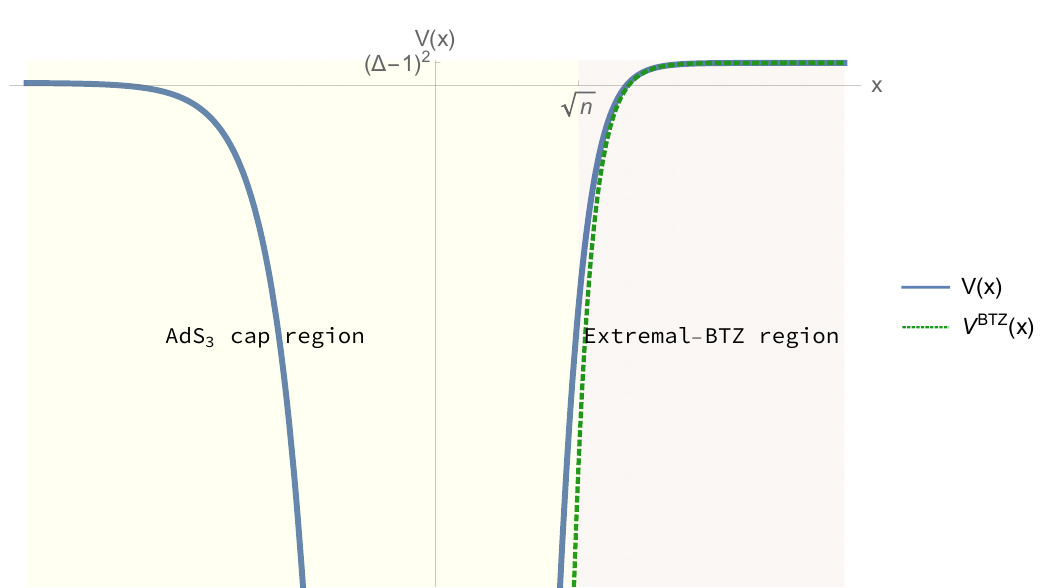
Figure 7: The extremal-BTZ regime: the superstratum potential V ( x ) and the approx- imated potential V BTZ ( x ) when 2